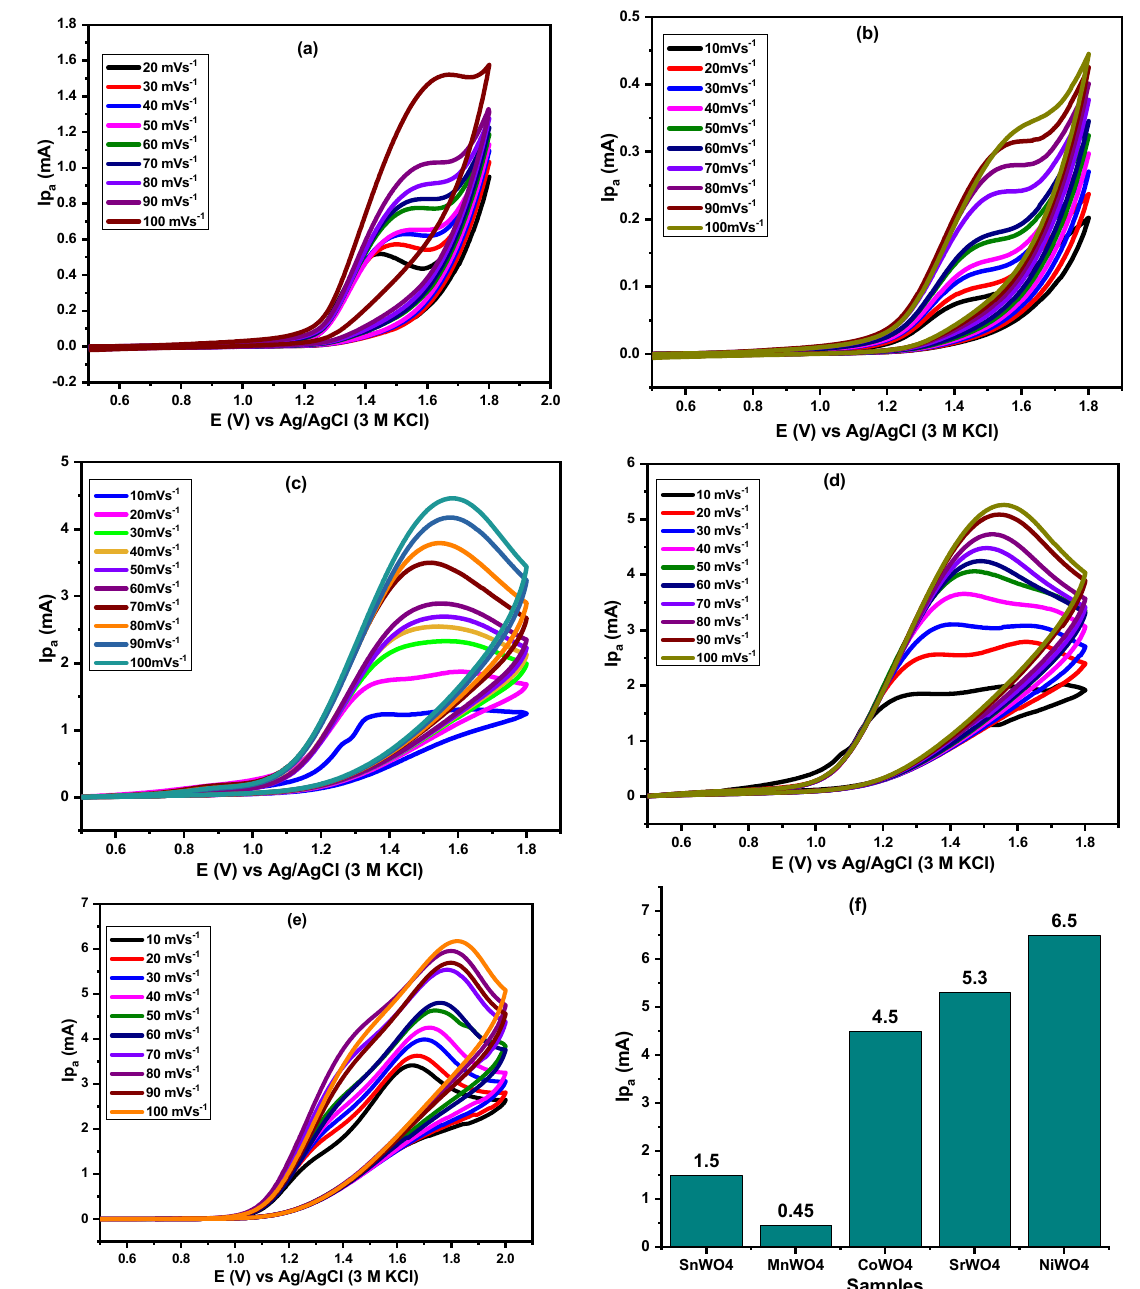
Figure 10. CV curves of water oxidation in 1 M KOH at different sweep rates (10–100 mVs − 1 ) of: ( a ) g-C 3 N 4 -SnWO 4 , ( b ) g-C 3 N 4 -MnWO 4 , ( c ) gC 3 N 4 -CoWO 4 , ( d ) g-C 3 N 4 -SrWO 4 , and ( e ) g-C 3 N 4 -NiWO 4 . ( f ) Comparative peak current of all nanocomposites at 100 mVs − 1 in 0.1 M KOH. Table 3. Kinetics parameters for water oxidation at g-C 3 N 4 /MetalWO 4 /GC. Samples